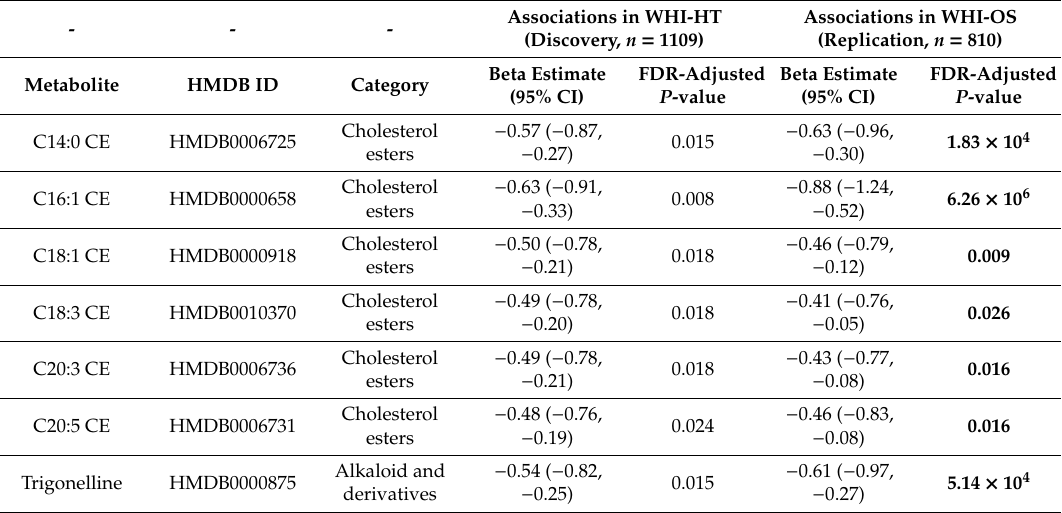
Table 4. Associations of the empirical dietary index for the hyperinsulinemia score with metabolites in the discovery of Women’s Health Initiative-Hormone Therapy (WHI-HT) and replication of WHI- Observational Study (WHI-OS) datasets 1,2,3